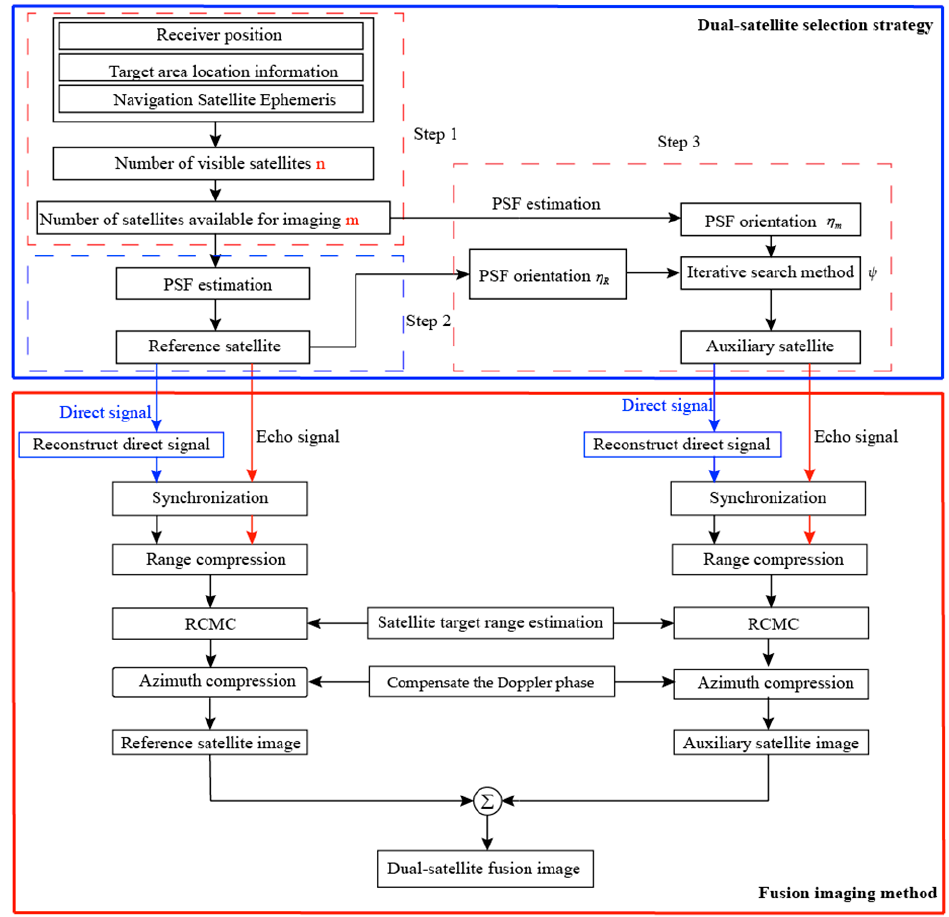
Figure 8. Flow chart of the improved dual-satellite fusion imaging method.